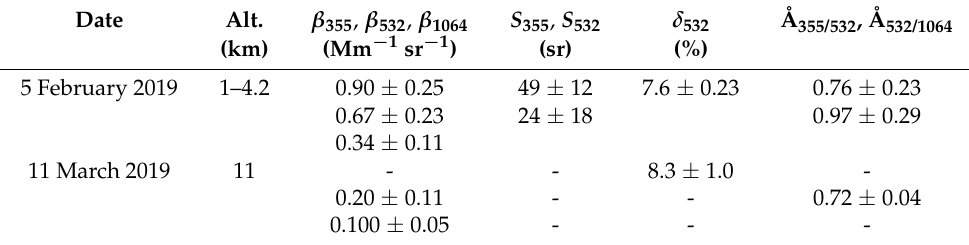
Table 1. Overview of aerosol optical properties as derived from Polly XT LACROS in Punta Arenas on 5 February 2019 and 11 March 2019. β is the backscatter coefficient, S the lidar ratio, δ the particle linear depolarization ratio and Å the backscatter-related Ångström exponent. The subscript indicates the corresponding wavelength. All values correspond to averaged (mean) values per examined layer along with the standard